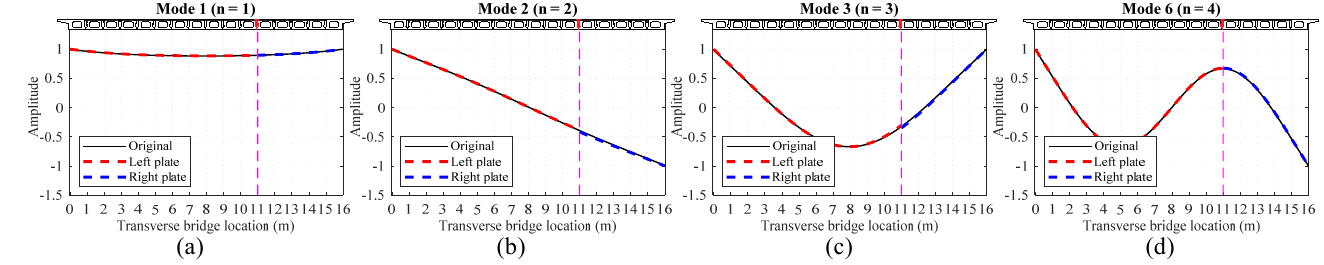
Figure 10. Comparison of the first four transverse modal shapes: hinge position η = 11 m: ( a ) Mode 1, n = 1; ( b ) Mode 2, n = 2; ( c ) Mode 3, n = 3; ( d ) Mode 6, n = 4.